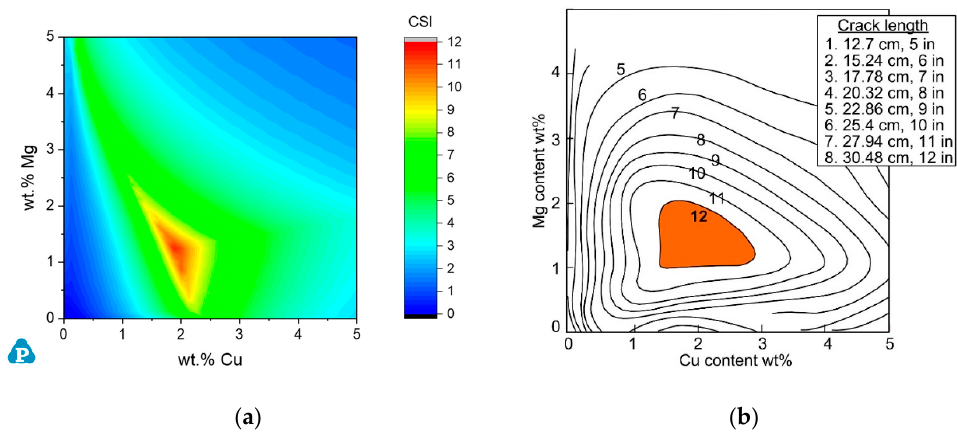
Figure 1. Al-Cu-Mg cracking susceptibility maps ( a ) by improved Scheil model considering back diffusion in the solid under the cooling rate of 20 ° C/s and ( b ) experimentally tested data [54] (Reprinted with permission from ref. [24]. Copyright 2017 Elsevier).